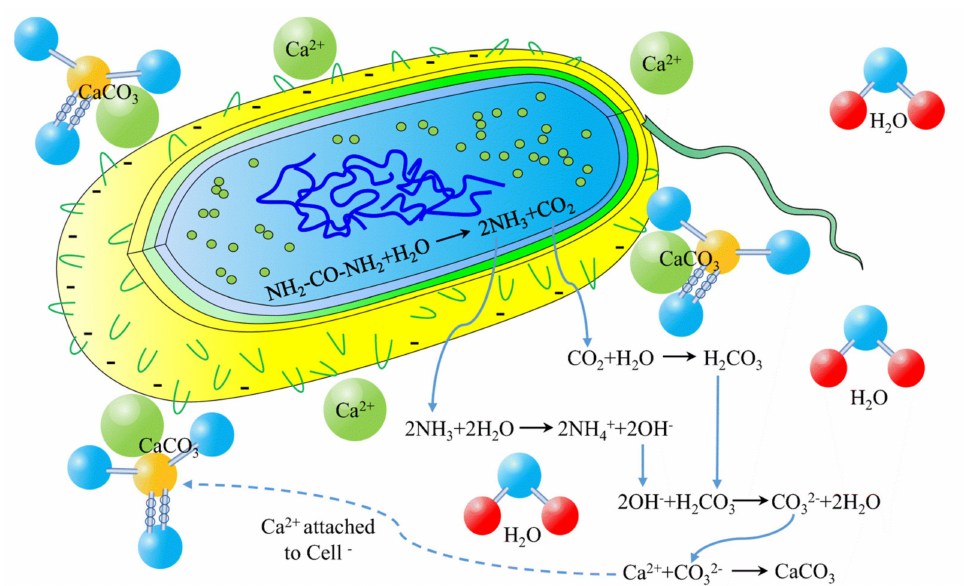
Figure 8. Schematic diagram of MICP based on urease-producing bacteria [60].